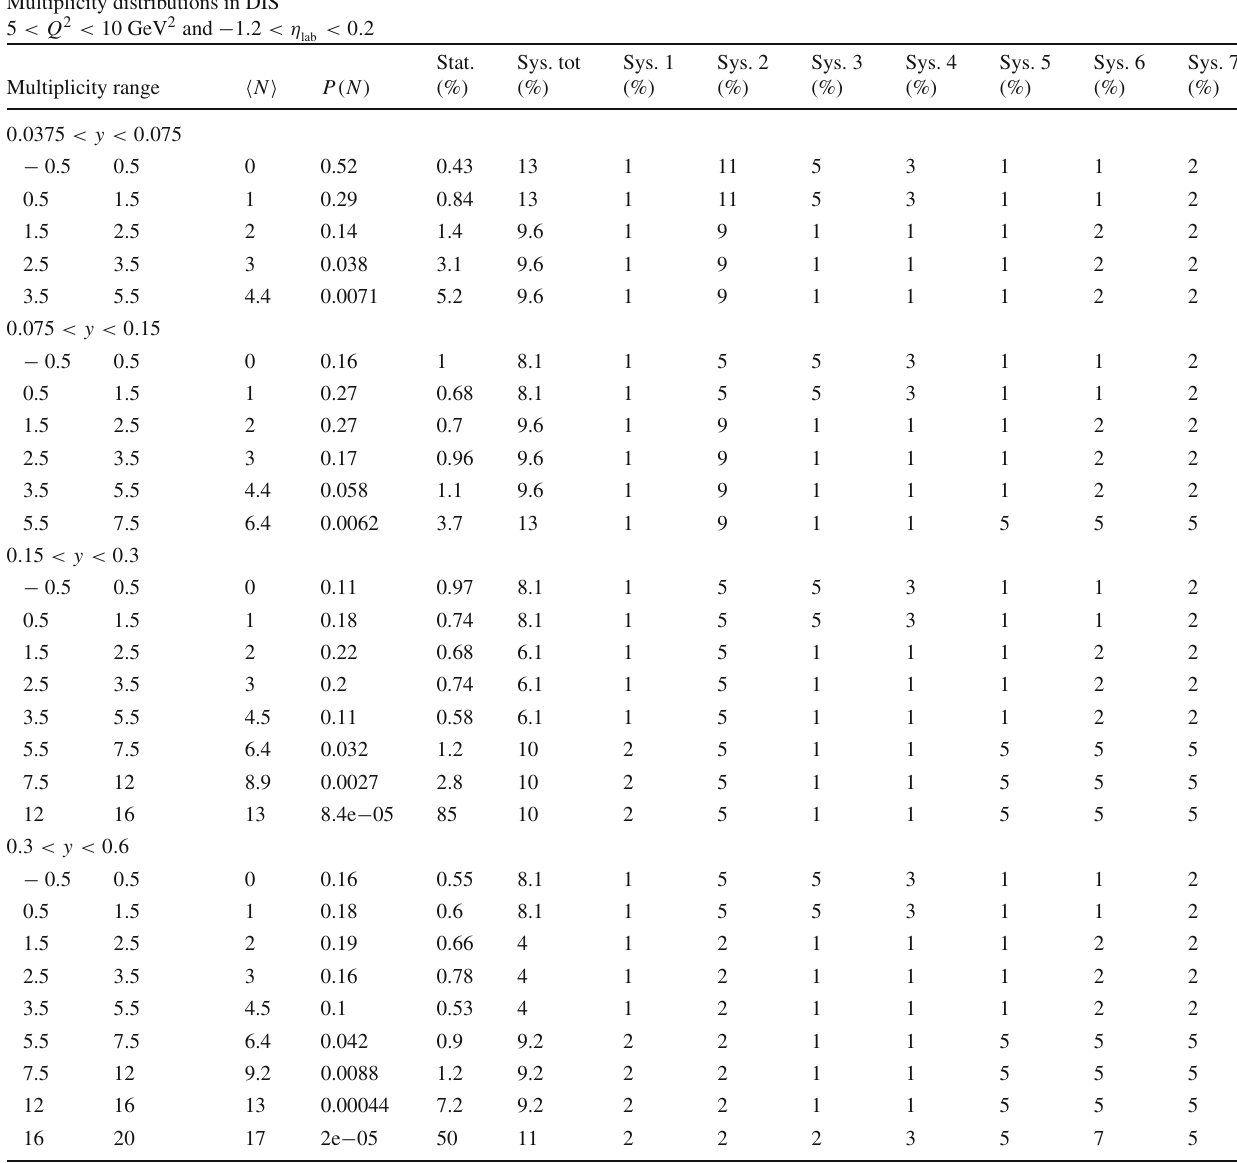
Table 13 Charged particle multiplicity distributions P ( N ) measured √ s = 319GeV with in the ranges of photon virtual- in ep DIS at ity 5 < Q 2 < 10 GeV 2 and charged particle pseudorapidity range Multiplicity distributions in DIS < 0 . 5 < Q 2 < 10 GeV 2 and − 1 . 2 < η lab